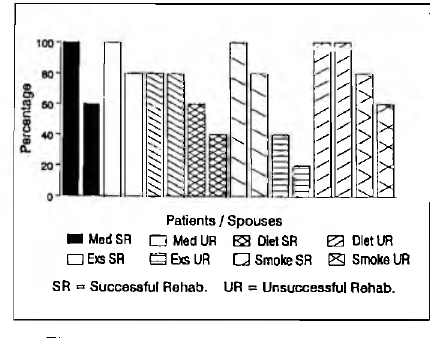
Figure 7. Assessment of Responsibility